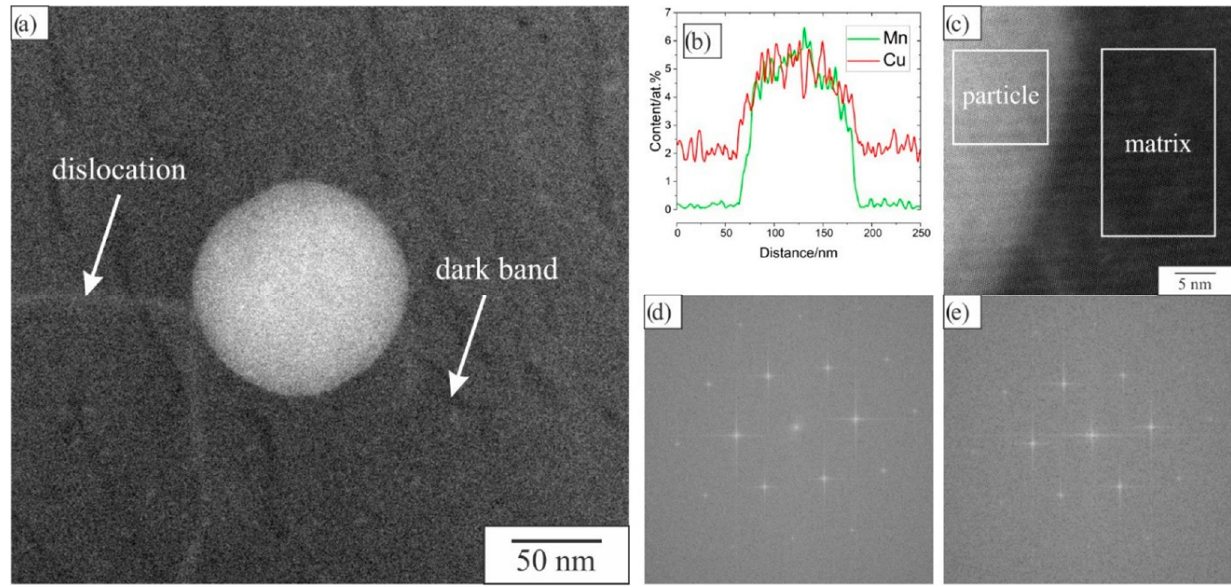
Figure 11. A spherical precipitate of sample FSP950 in the NZ. ( a ) The HAADF STEM micrograph, ( b ) EDS linescans for Cu and Mn, ( c ) High-resolution STEM image at the interface between the matrix and particle, ( d ) FFT of the matrix ([110] zone axis), and ( e ) FFT of the particle (only matrix diffraction spots can be seen).